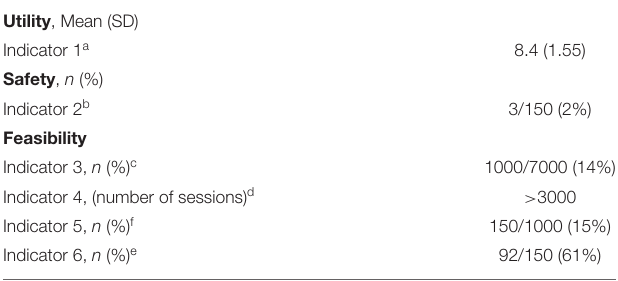
TABLE 1 | Utility, safety and feasibility outcomes. TABLE 2 | Characteristics of the participants.